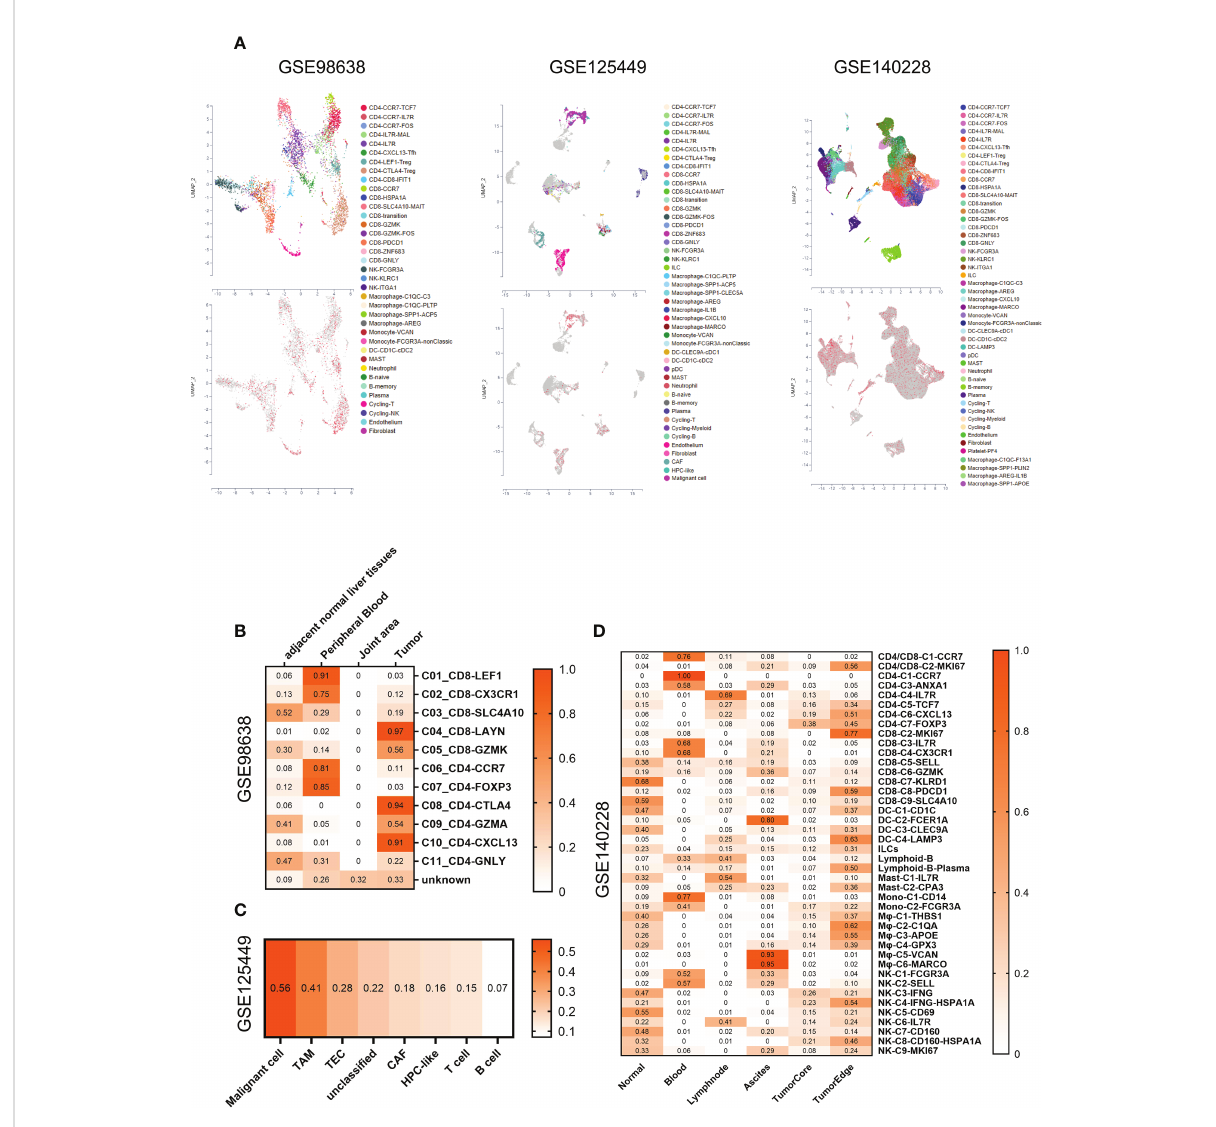
FIGURE 5 SMS expression within the tumor immune microenvironment of HCC. (A) UMAP annotated with cell types (Up panel) and colored by SMS positive cells (red) and none (gray) (Down panel). (B – D) Heatmaps of SMS gene expression positivity rates for each immune cell subset in GSE98638 (B) , GSE125449 (C) , and GSE140228 (D)